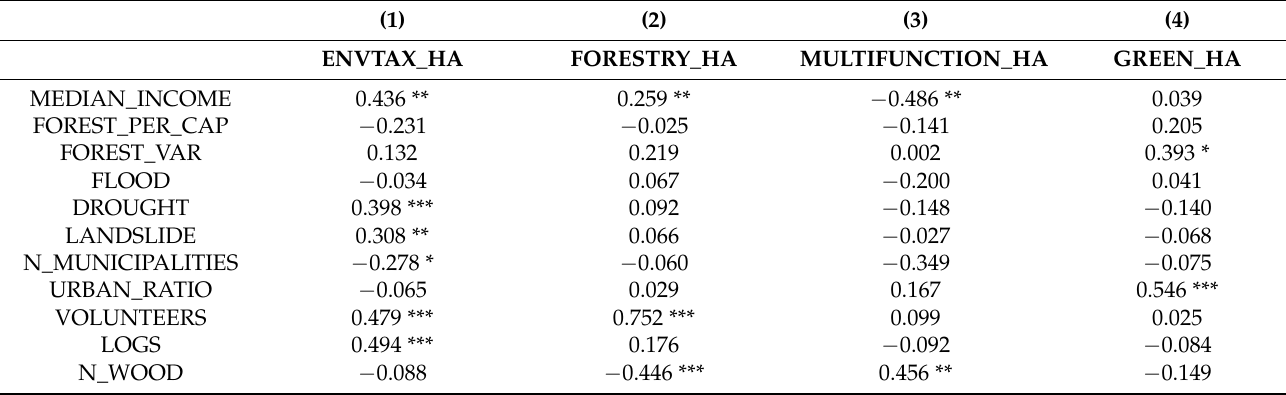
Table 4. Standardized beta